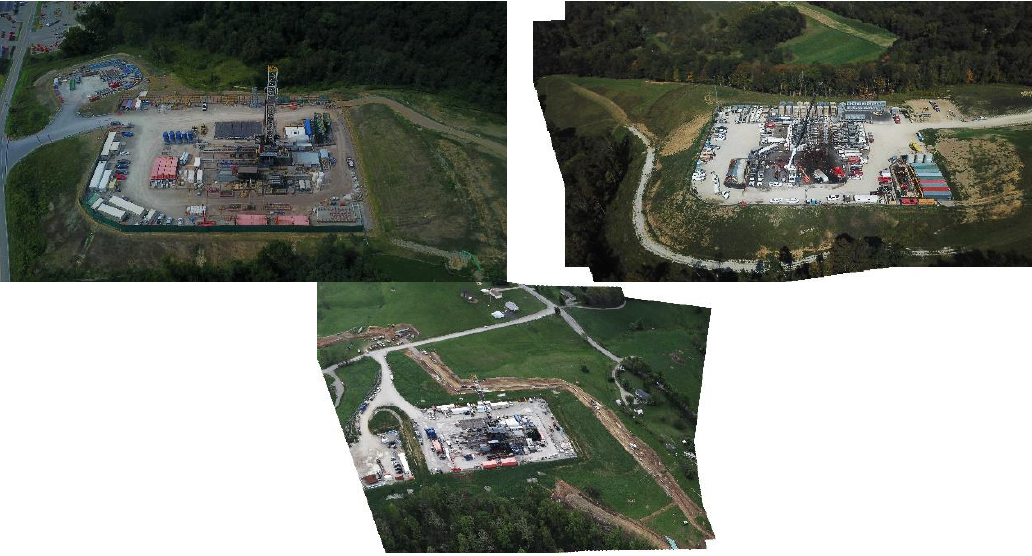
Figure 3. Examples of a typical hydraulic fracturing well pad in Eastern Ohio including a record breaking lateral pad at the Walleye Pad (Top-Left).